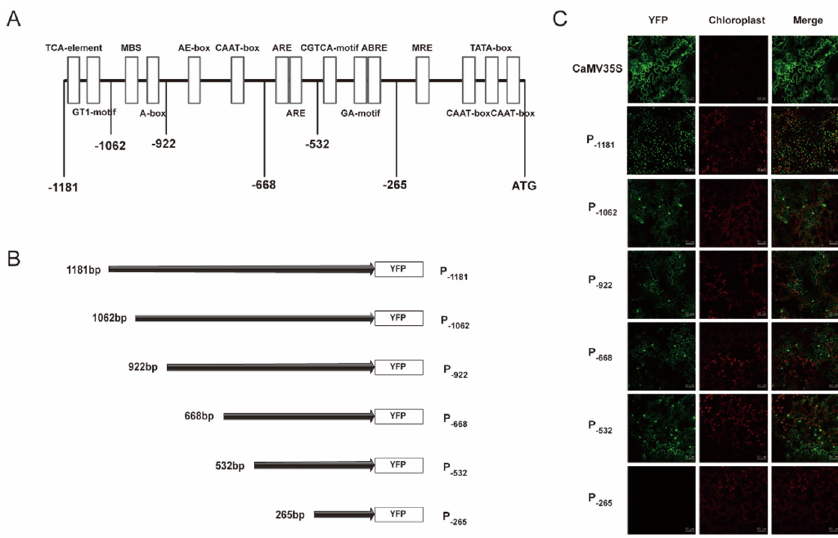
Figure 4. Construction for the PtAOS1 promoter and transient expression in tobacco leaves. ( A ) Schematic diagram for the PtAOS1 promoter. Boxes indicate cis-acting element in the promoter; ( B ) schematic diagrams of the truncated promoter construct; ( C ) transient expression of yellow fluorescent protein (YFP) driven by truncated promoter fragments in tobacco leaves.